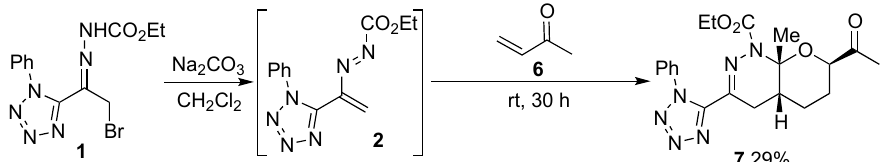
Scheme 2. Reaction of ethyl 3-(1-phenyl-1 H -tetrazol-5-yl)-1,2-diaza-1,3-butadiene-1-carboxylate ( 2